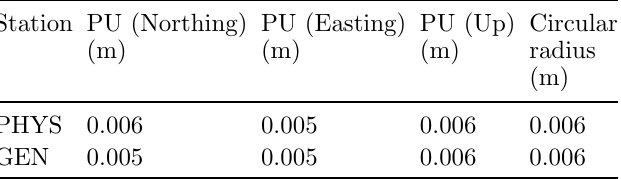
< 15 mm, SU horizontal